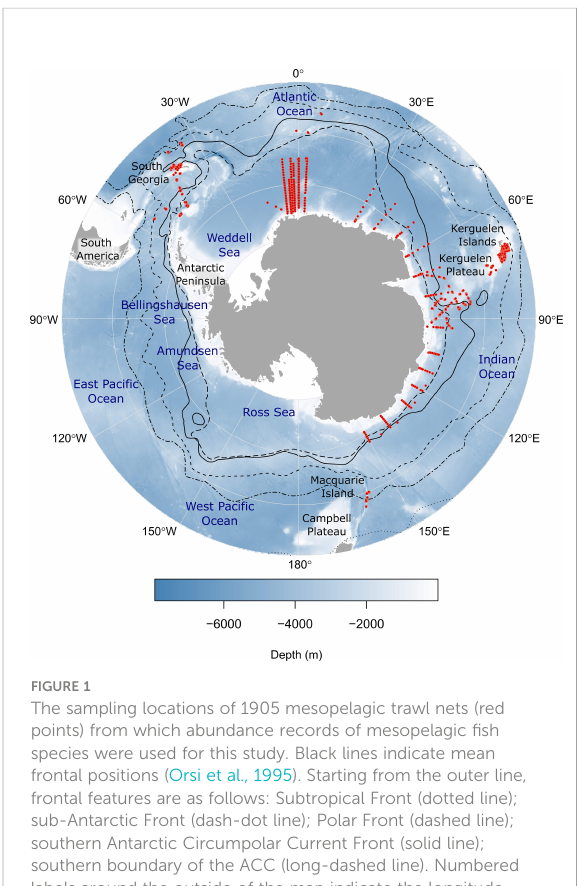
FIGURE 1 The sampling locations of 1905 mesopelagic trawl nets (red points) from which abundance records of mesopelagic fi sh species were used for this study. Black lines indicate mean frontal positions (Orsi et al., 1995). Starting from the outer line, frontal features are as follows: Subtropical Front (dotted line); sub-Antarctic Front (dash-dot line); Polar Front (dashed line); southern Antarctic Circumpolar Current Front (solid line); southern boundary of the ACC (long-dashed line). Numbered labels around the outside of the map indicate the longitude. Each latitude line represents 10° of latitude where 75°S is at the Antarctic continent and 45°S is at the external